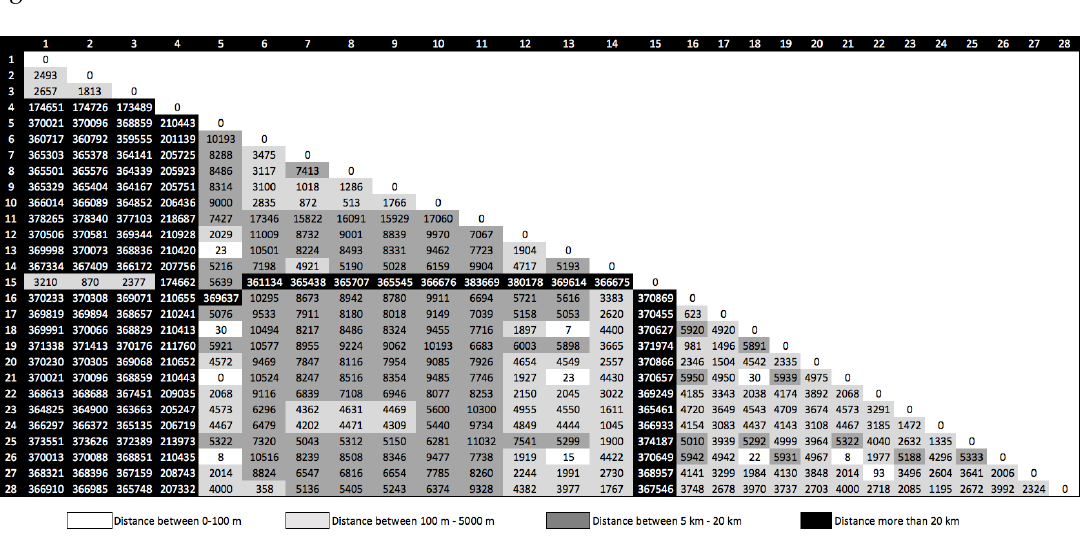
Figure 4. Distance matrix between the locations with different main distance